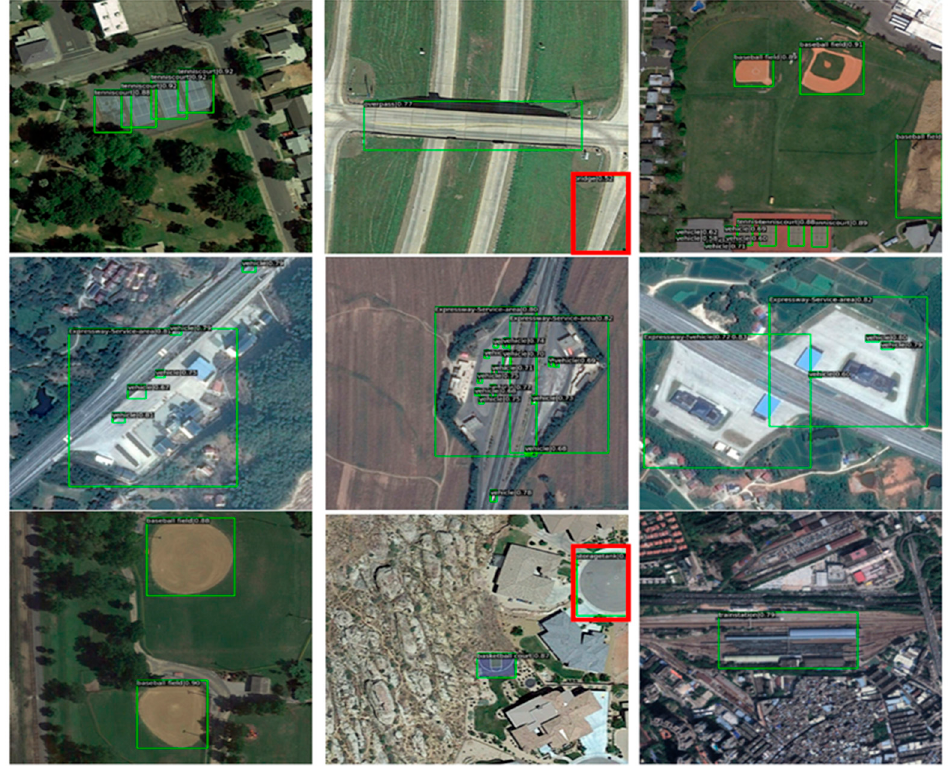
Figure 10. The DIOR dataset’s visualized test results using different algorithms. Table 6. Comparative experimental results of different algorithms on the DIOR dataset.